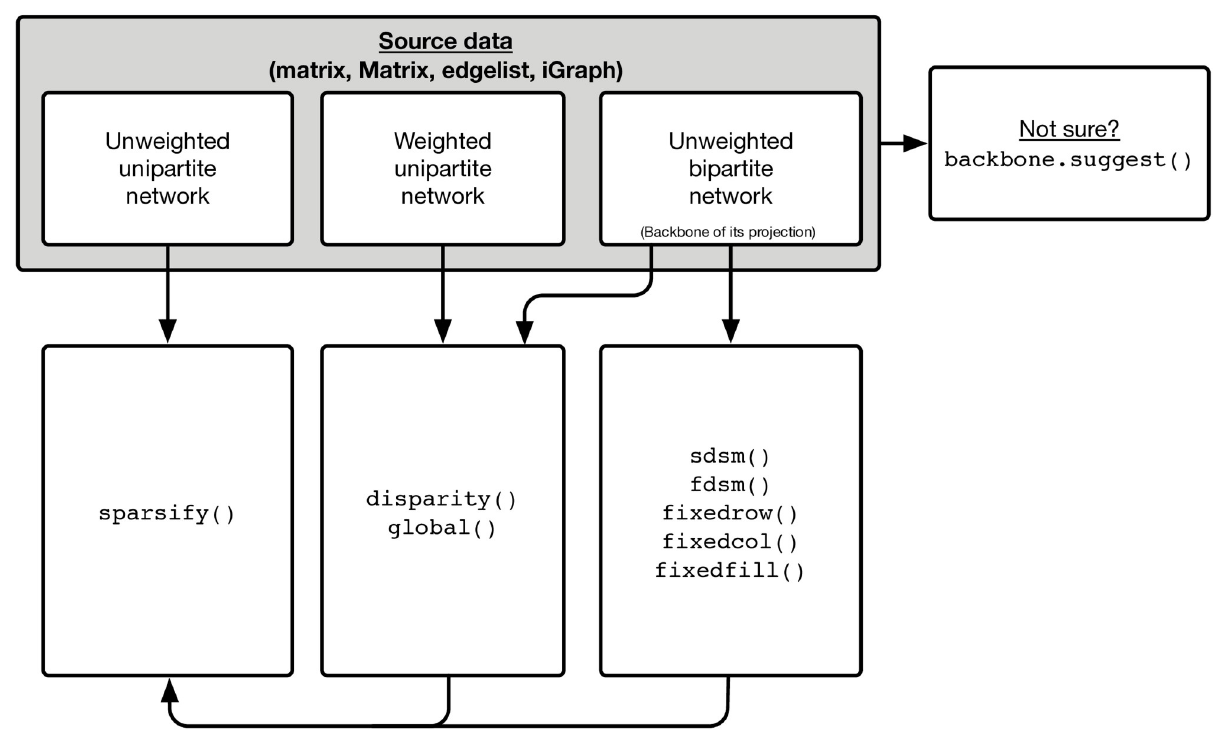
Fig 1. Workflow of the backbone